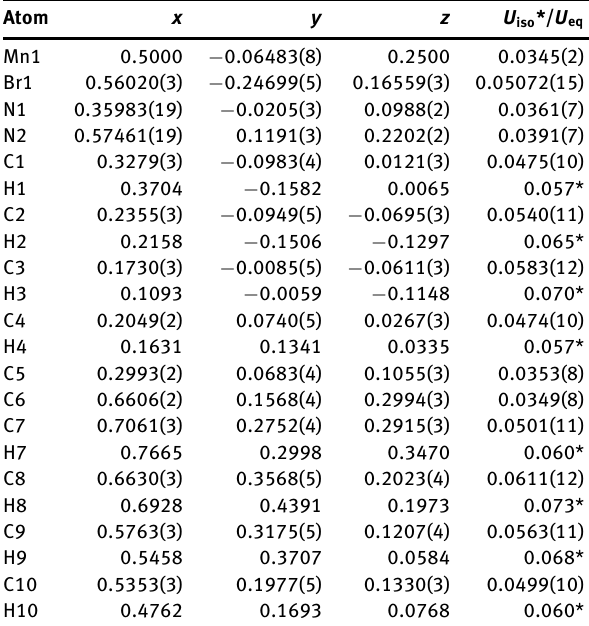
Table 2: Fractional atomic coordinates and isotropic or equivalent isotropic displacement parameters (Å 2